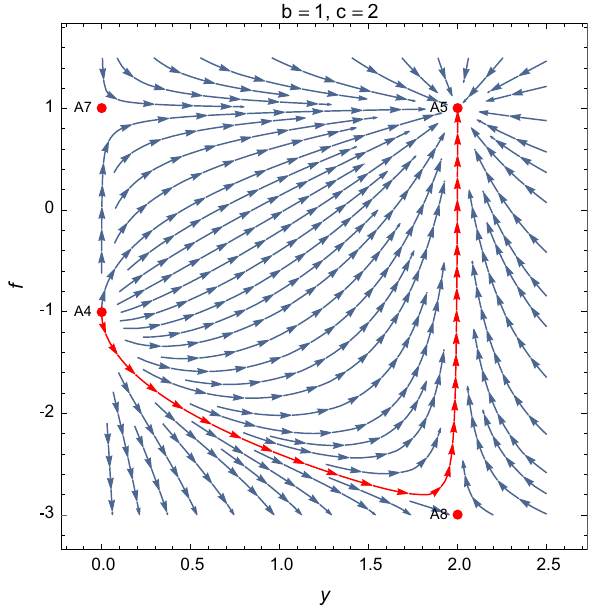
Fig. 2 The projection of the phase portrait of the model on the yf - planeforthestandardnon-minimalcoupling h ∝ φ 2 andtheHiggs-type potential V ∝ φ 4 ( b = 1, c = 4), with w m = 0. The de Sitter solution for the point A5 also shows an attractor character on the plane yf . The points A4 and A7 present a behavior similar to the case c = 2 Thus, the values b = 4 , c = 4, give w eff ≈ − 0 . 91